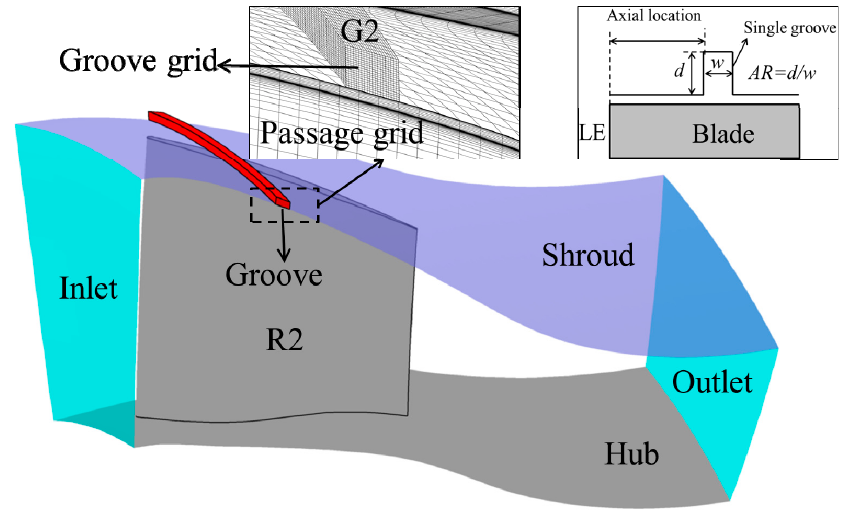
Figure 2. Schematic of the circumferential grooved CTs and enlarged view of grid near the groove.